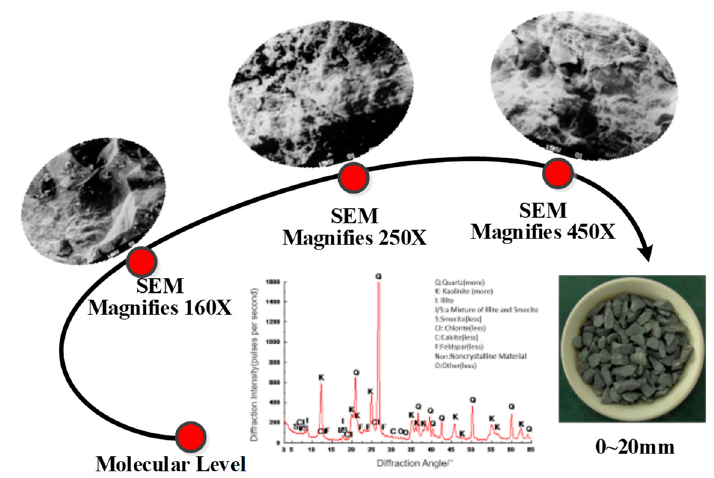
Figure 5. Mineral compositions and mesostructural characteristics of gangues.